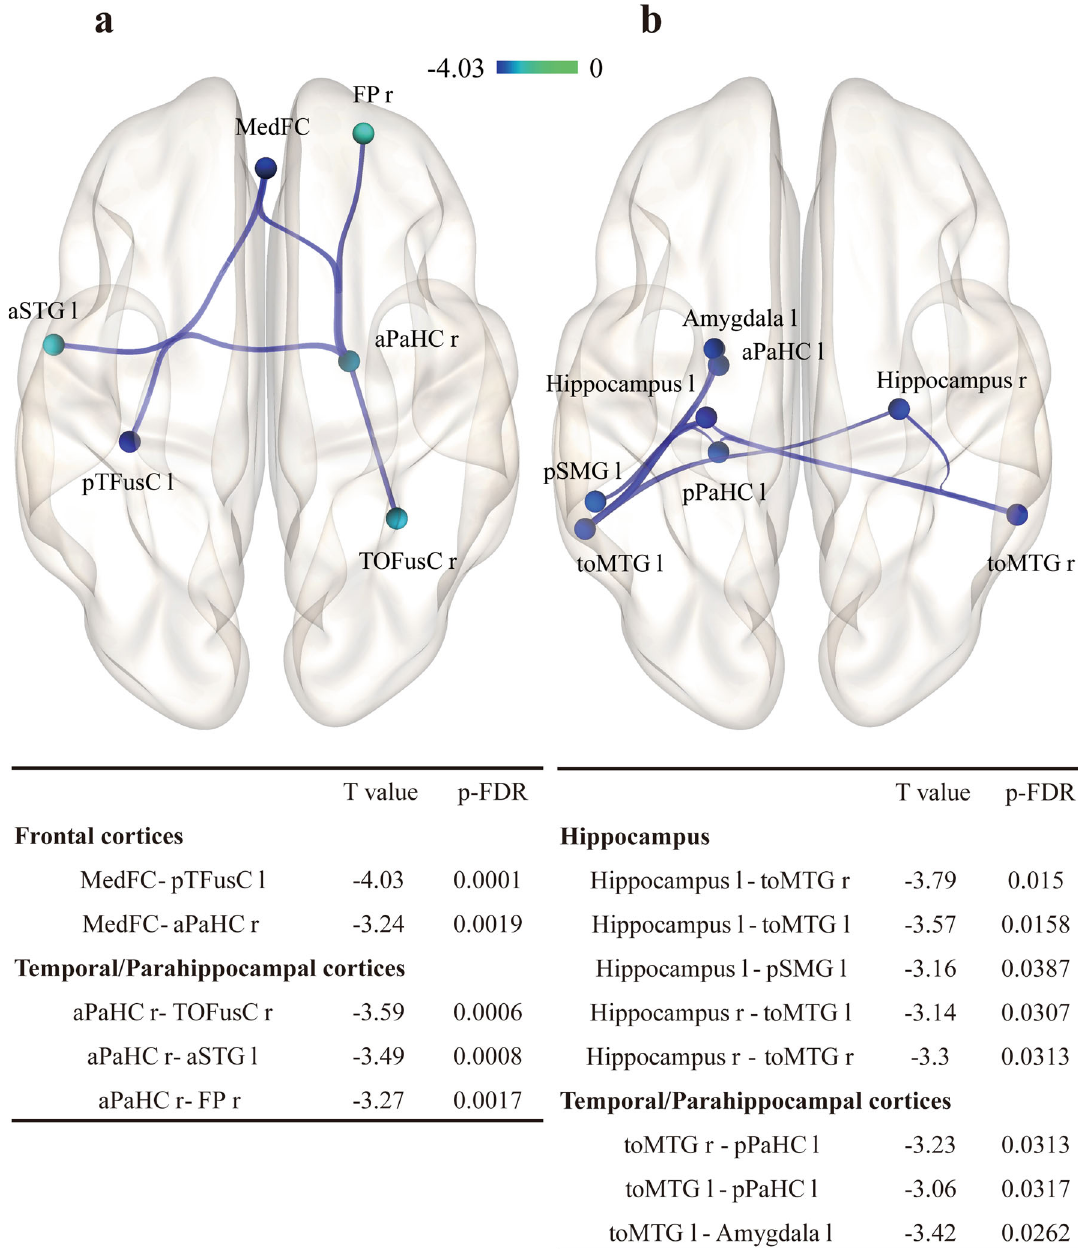
Fig. 4 Functional networks showing pareidolia score- and MMSE score- dependent alteration. a (left): Regression analysis of functional connectivity revealing pareidolia score-dependent decrement. Functional connectivity between the MedFC and pTFusC was negatively correlated with the pareidolia score. b (right): Regression analysis of functional connectivity revealing the MMSE score-dependent decrement. Functional connectivity between the bilateral hippocampus and middle temporal gyrus was negatively correlated with MMSE score. T values of the negative difference in functional connectivity are shown as a colored bar. The statistical signi fi cance was set to an FDR-p < 0.05. MMSE Mini-Mental State Examination, r right, l left, MedFC medial frontal cortices, pTFusC temporal fusiform cortex posterior division, TOFusC temporal occipital fusiform cortex, aSTG superior temporal gyrus anterior, FP frontal pole, pSMG supramarginal gyrus posterior division, toMTG middle temporal gyrus temporooccipital part, aPaHC right parahippocampal gyrus anterior division, pPaHC parahippocampal gyrus posterior